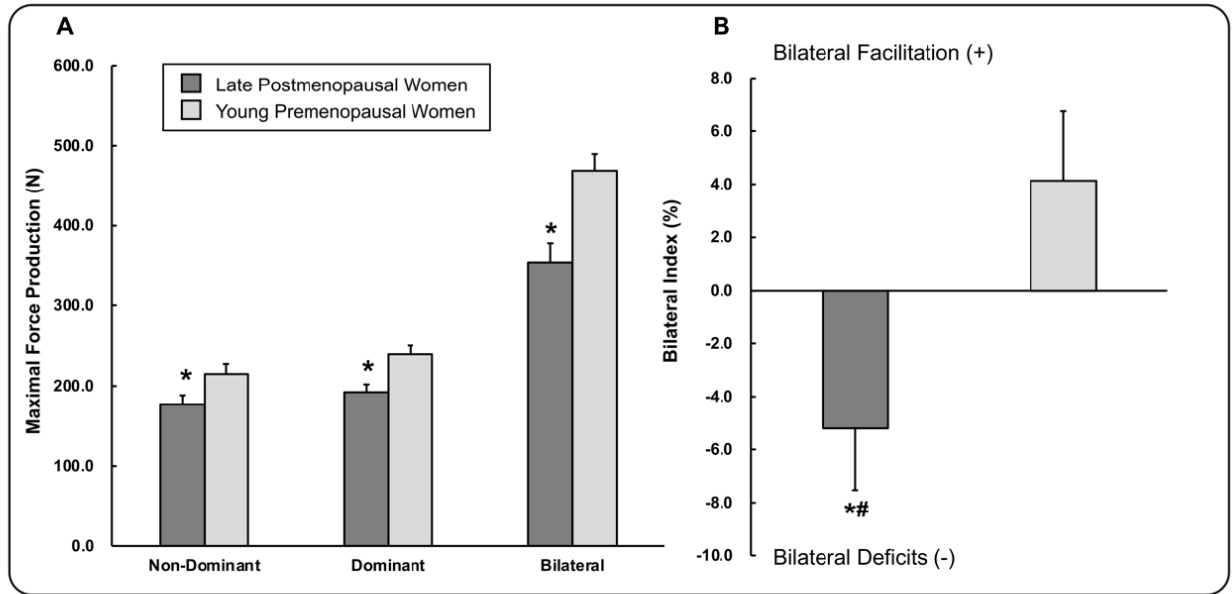
Figure 2. Maximal force production and bilateral index during isometric hand-grip force production tasks (M ± SE). ( A ) Maximal force production and ( B ) bilateral index. Asterisk (*) indicates significant difference ( p < 0.05) between late postmenopausal and young premenopausal women. Number sign (#) indicates significant difference ( p < 0.05) from zero.